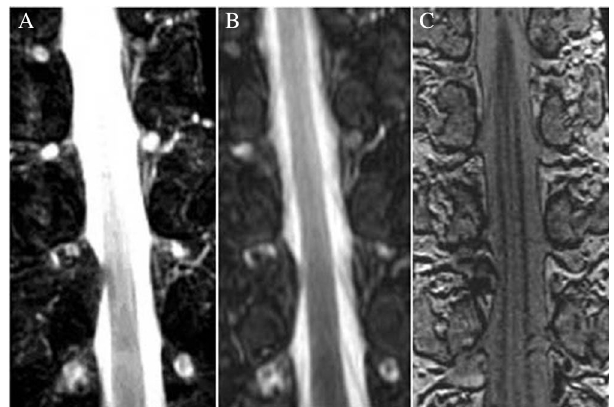
Figure 2. Different MRI sequences show DRG locations. ( A ) FSE-STIR T2WI; ( B ) Fs-FRFSE T2WI; ( C ) 3D FIESTA-c.